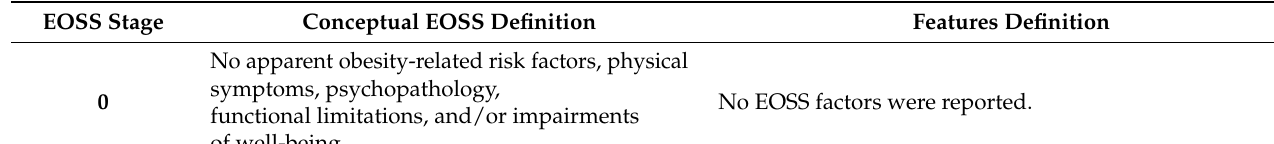
Table 2. Edmonton Obesity Staging System (EOSS) definitions